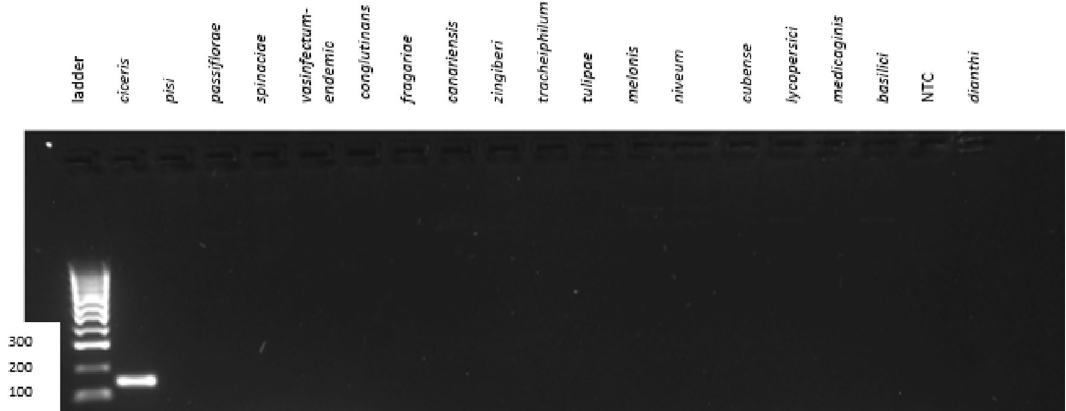
Figure 3. Agarose gel showing amplification products from PCR using genomic Fusarium oxysporum f. sp. c iceris (Foc) DNA. Lane 2 with Foc DNA amplified showing a product size of 143 bp. There is no amplification from any other ff.